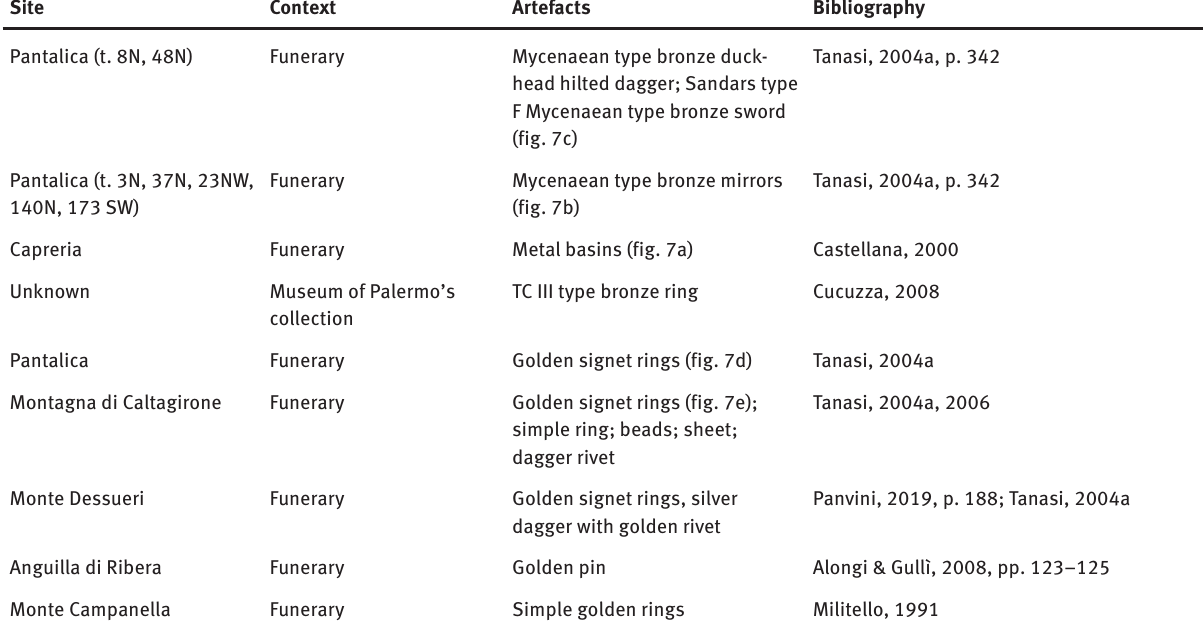
Table 8: Metals Artefacts of Mycenaean Origin in Middle Bronze Age Sicily and